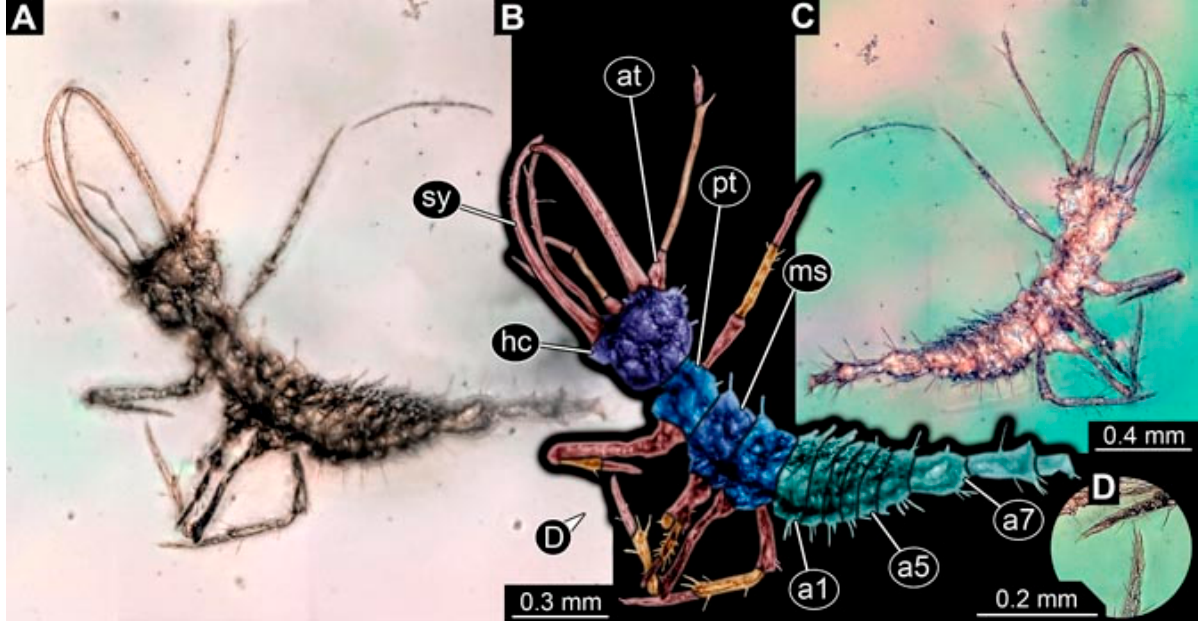
Figure 23. Specimen 4844 (PED 0518); Myanmar amber. ( A ) Dorsal view. ( B ) Dorsal view, colour- marked. ( C ) Ventral view. ( D ) Close-up of distal end of trunk appendage. Abbreviations: a1, 5, 7 = abdomen segments 1, 5, 7; at = antenna; hc = head capsule; ms = mesothorax; pt = prothorax; sy = stylet.